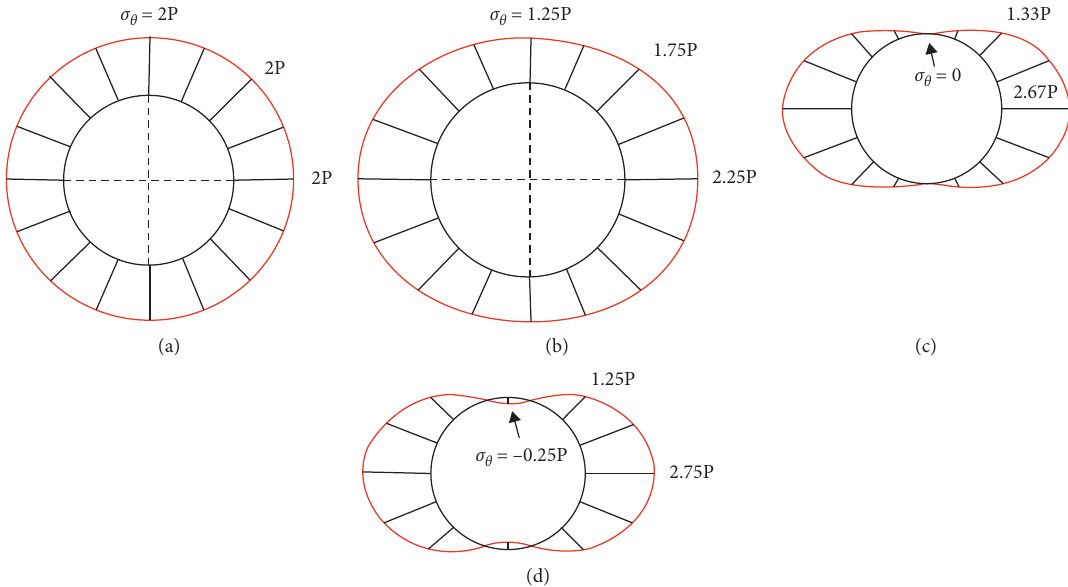
Figure 3: Hoop stresses distribution on the opening wall: (a) λ � 1.00, (b) λ � 0.75, (c) λ � 0.33, and (d) λ � 0.25.